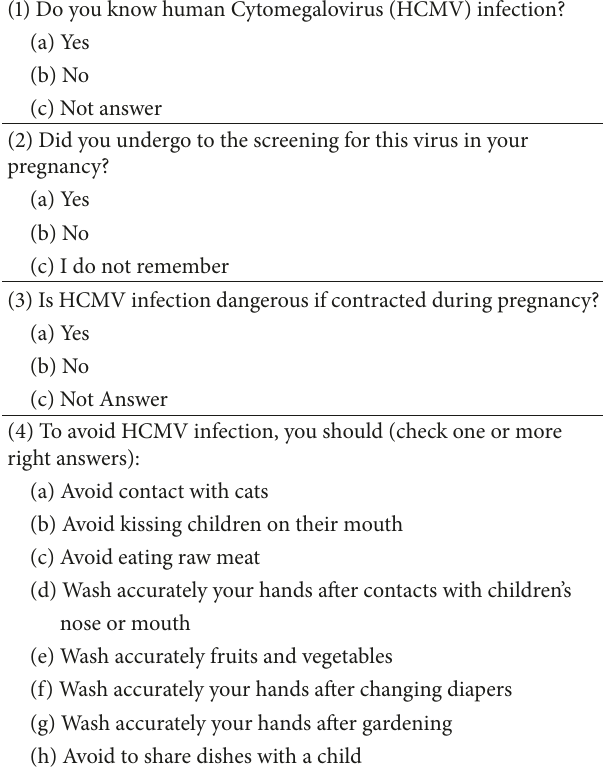
Table 1: Questions and answers included in the multiple-choice